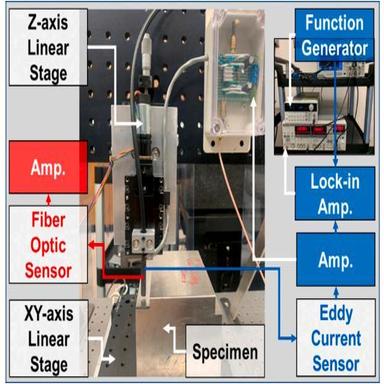
The scanning system attaching the fiber optic eddy current sensor for scanning the part.